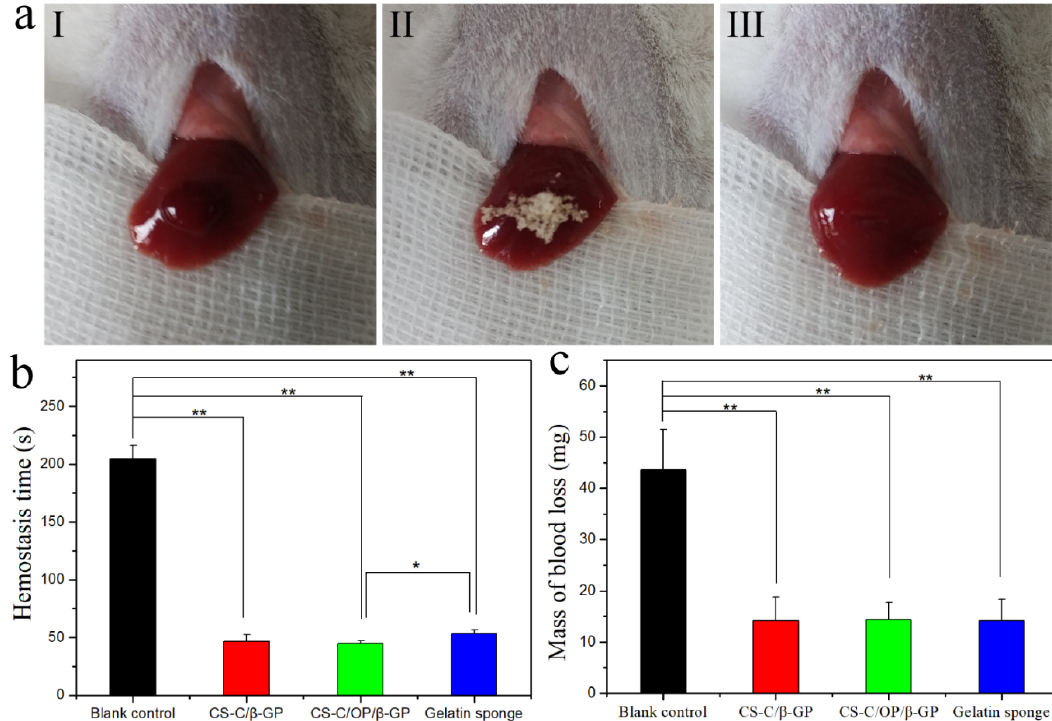
Figure 4. Hemostasis of the liver laceration ( a ) (I: liver bleeding; II: liver hemostasis; III: wound after hemostasis), hemostasis time ( b ), and mass of blood loss ( c ) in a liver injury model, * p < 0.05 and ** p < 0.01.